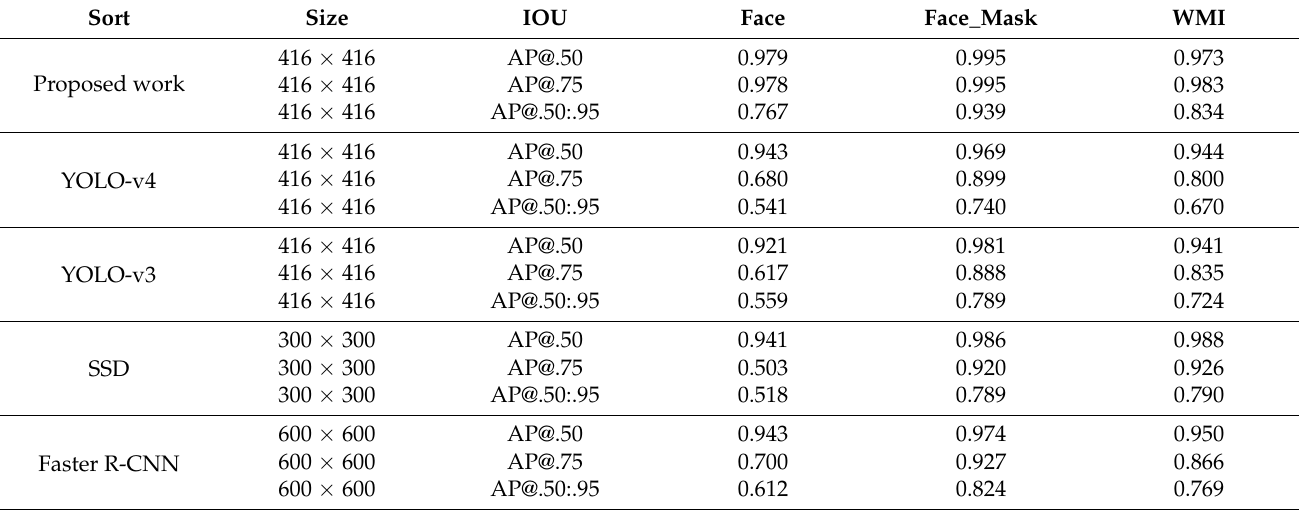
Table 9. The comparative experiments of AP of different models in three categories.